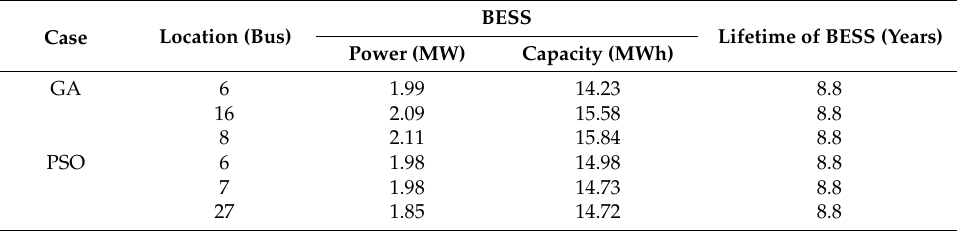
Table 1. Optimal siting and sizing of the battery energy storage system (BESS)